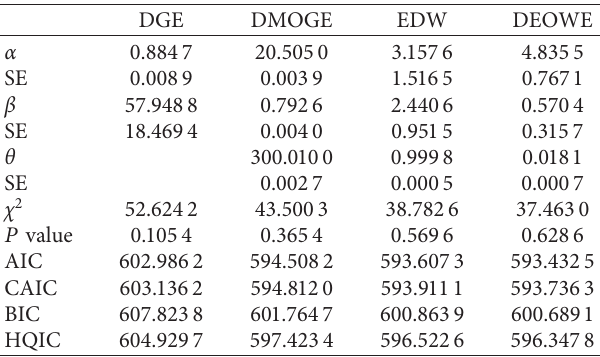
Table 12: MLE and SE for models’ parameters and goodness-of-fit criteria for each